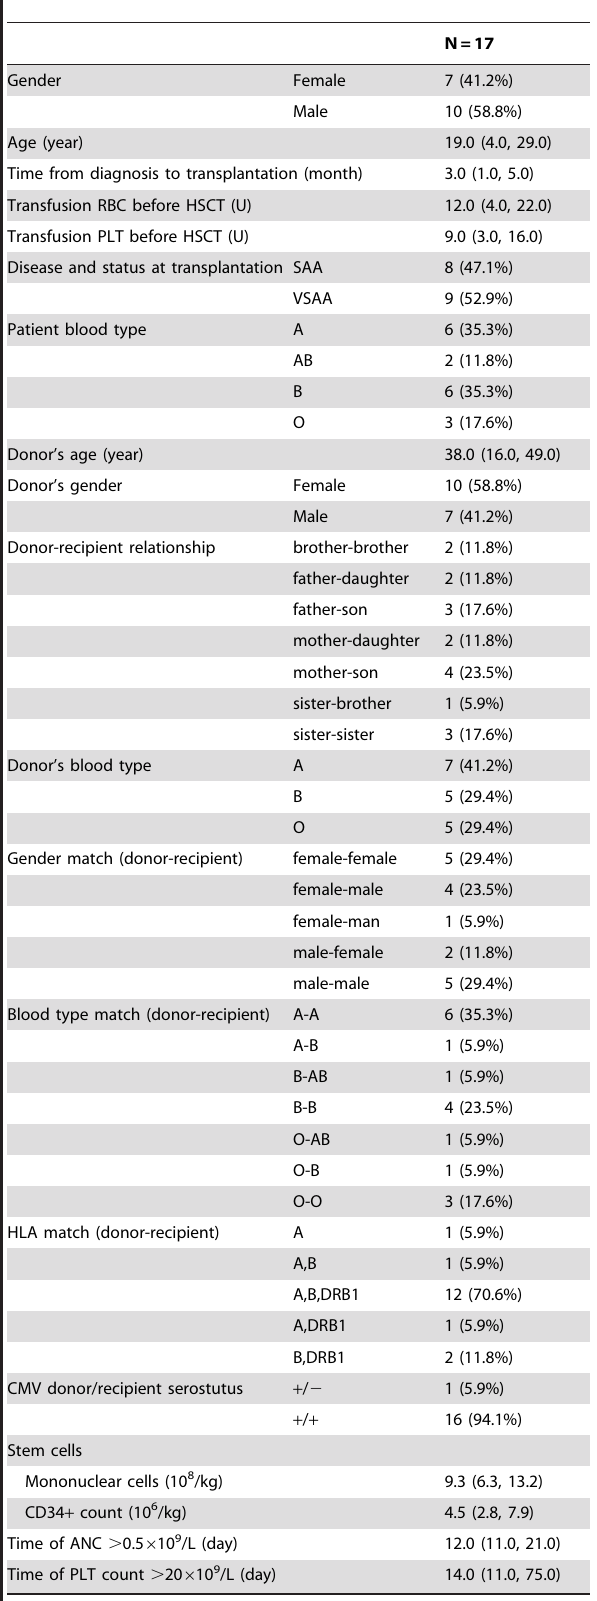
Table 1. The characteristics of 17 patients treated with haploidentical